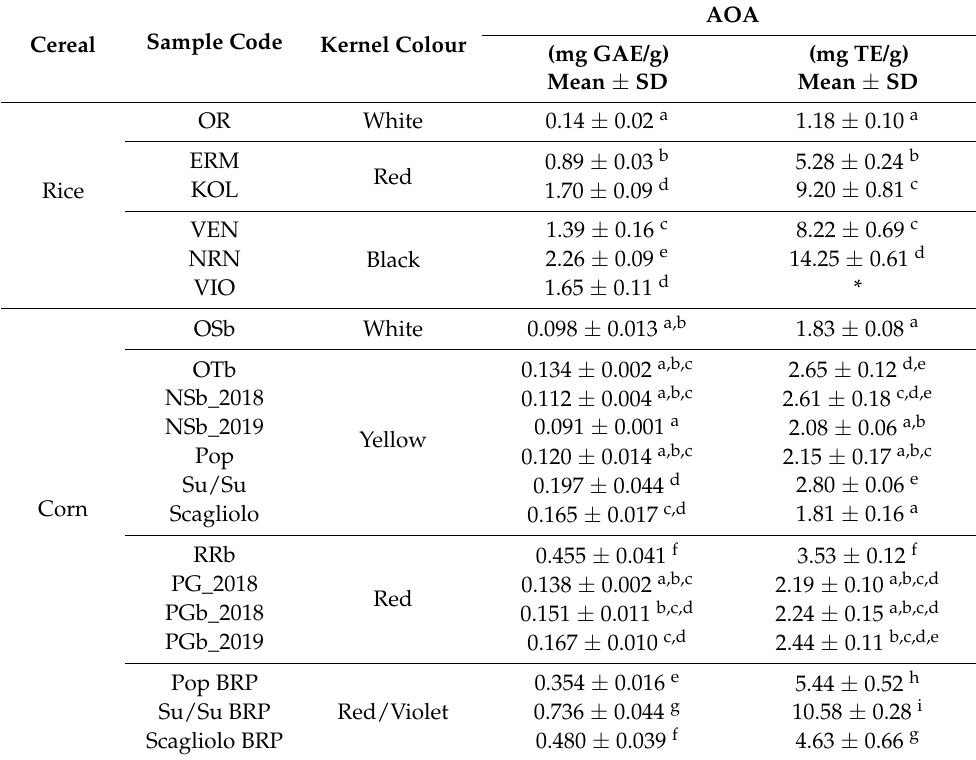
Table 4. Antioxidant activity (AOA) of rice and corn varieties.